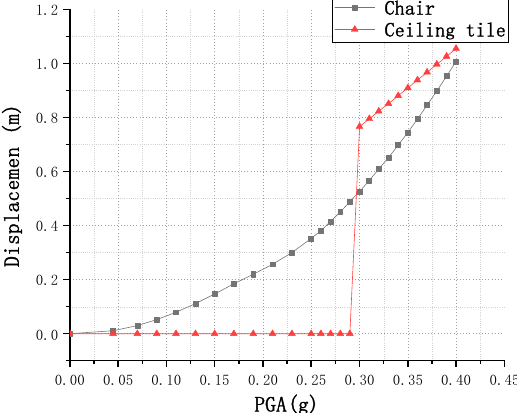
Figure 14. Horizontal displacements of a ceiling tile and a chair with different PGAs.